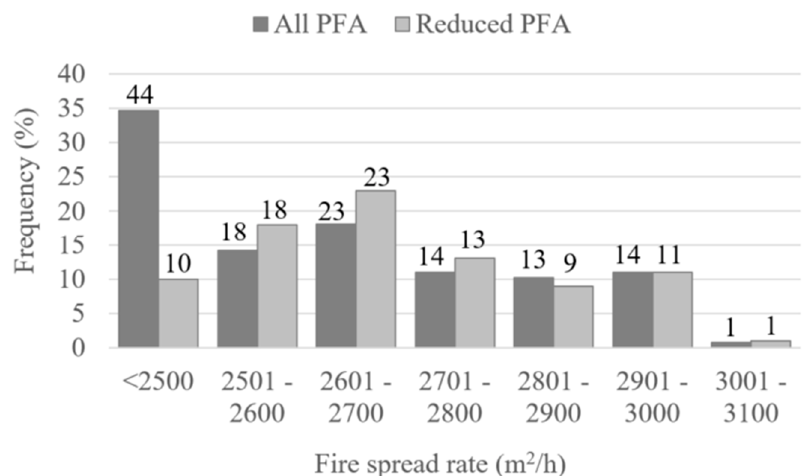
Figure 17. Histogram showing the predicted fire spread rates for all PFAs greater than 1 ha and also a reduced subset of PFAs where the spatial metrics of the PFA correspond with the spatial metrics used to develop the equation, shown as “Reduced PFA” on the graph. The count is displayed above each bar.